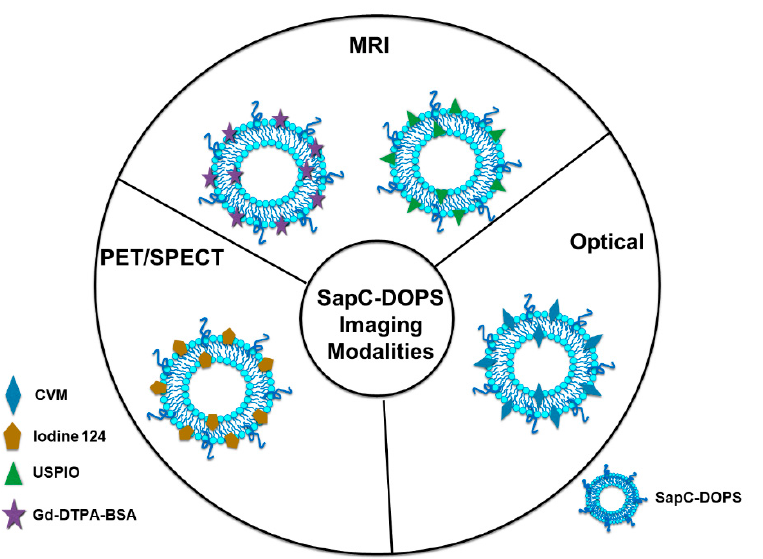
Figure 2. Schematic representation of saposin C-dioleoylphosphatidylserine (SapC-DOPS)-based tumor imaging modalities. For in vivo and in vitro studies, SapC-DOPS nanovesicles can be labeled with far-red fluorophore, CellVue Maroon (CVM) for optical imaging. For in vivo magnetic reso- nance imaging (MRI) imaging, the gadolinium chelates, gadolinium-DTPA-bis(stearylamide) (Gd- DTAP-BSA) or the ultrasmall superparamagnetic iron oxide (USPIO) can be incorporated and used as MRI contrast agents. For in vivo positron emission tomography (PET)/single-photon emission computed tomography (SPECT) imaging, SapC-DOPS can be combined with iodine-124 contrast